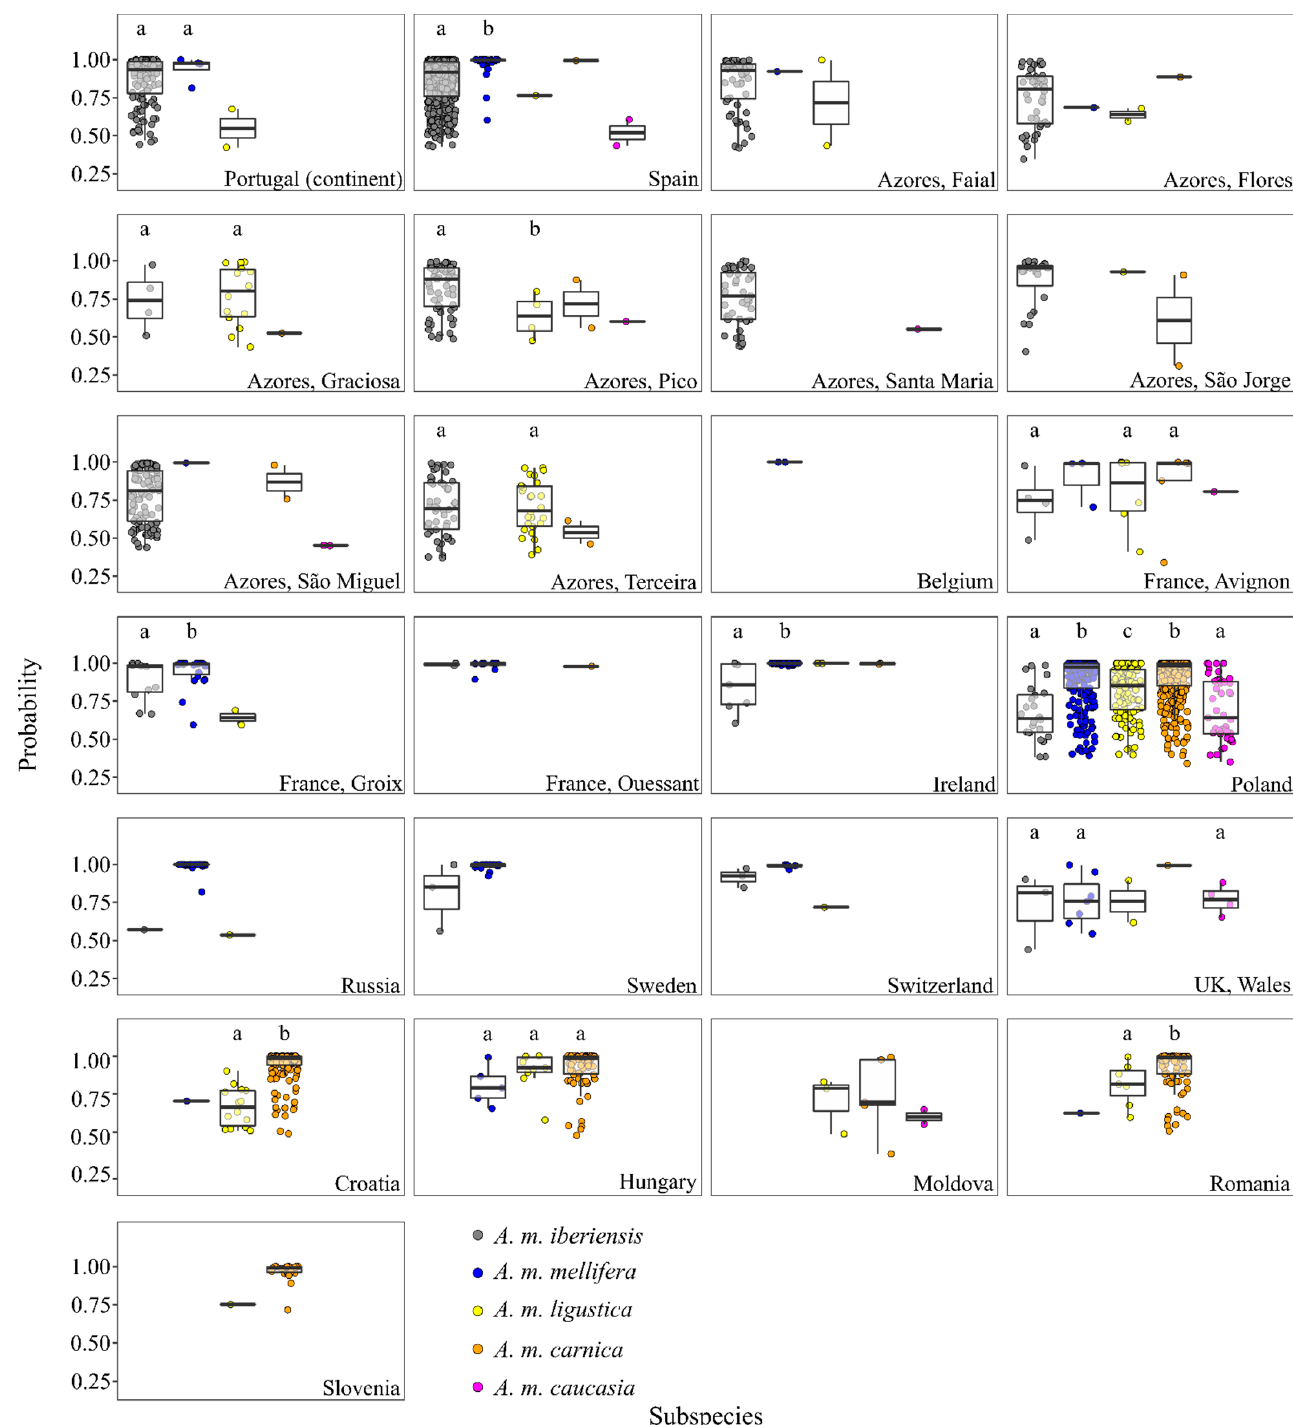
Figure 2. Classification probabilities calculated for colonies from the average wing with DeepWings©. Each dot represents a colony. Boxplots represent the median, interquartile range, maximum, and minimum. Groups with the same letter on top have similar distributions in the classification probabilities. Groups with different letters have different distributions in the classification probabilities for a significance level of 0.05.